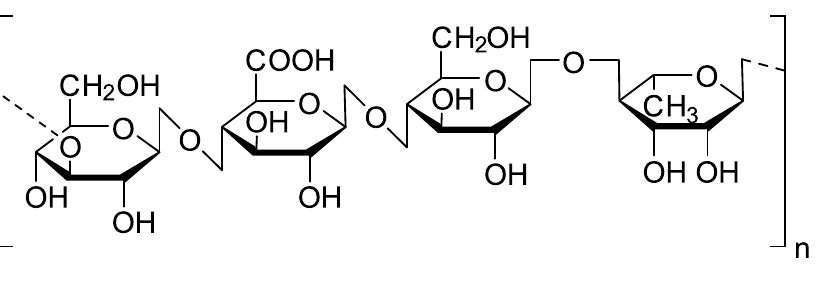
Fig 1. Repeating tetrasaccharide unit of low acyl gellan gum. Low acyl gellan gum consists of the repeating tetrasaccharide unit ([D-Glc( β 1 ! 4)D-GlcA( β 1 ! 4)D-Glc( β 1 ! 4)L-Rha( α 1 ! 3)] n ) of low acyl gellan